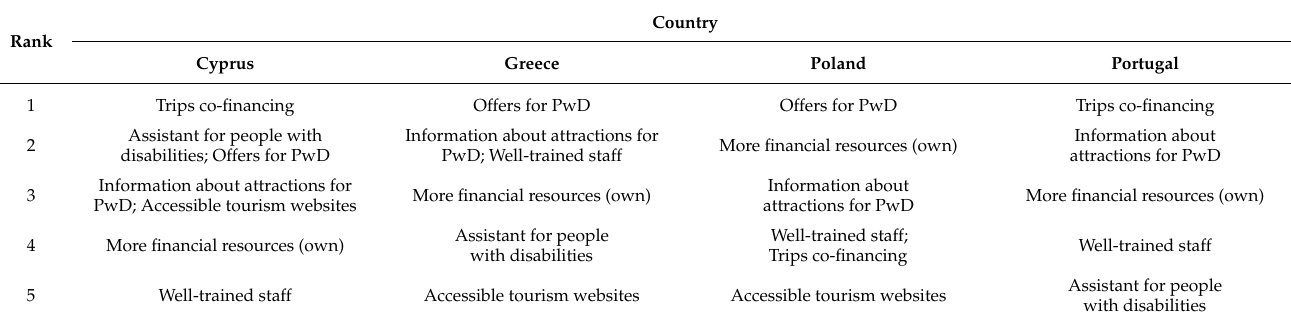
Table 6. Most important factors that would make travelling easier by country.